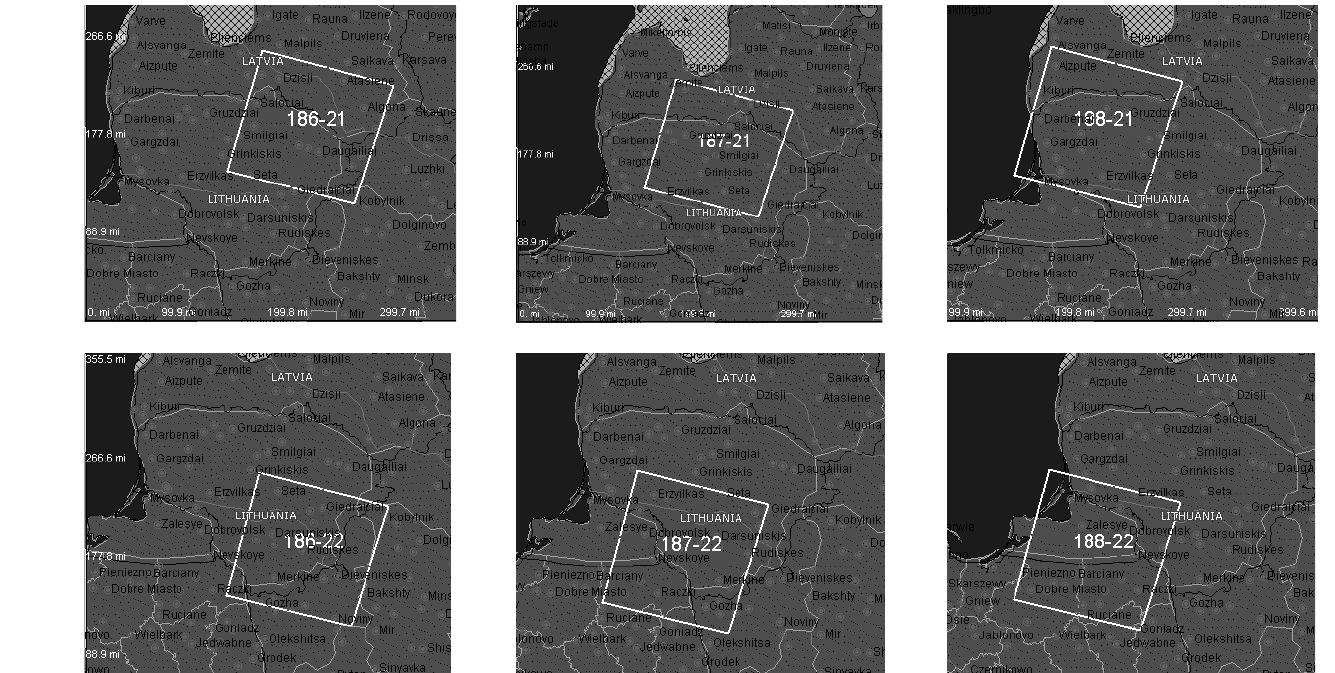
Fig 5 . Numbers of multispectral image scenes for the territory of Lithuania Tinkamo laiko parinkimas palydovinei